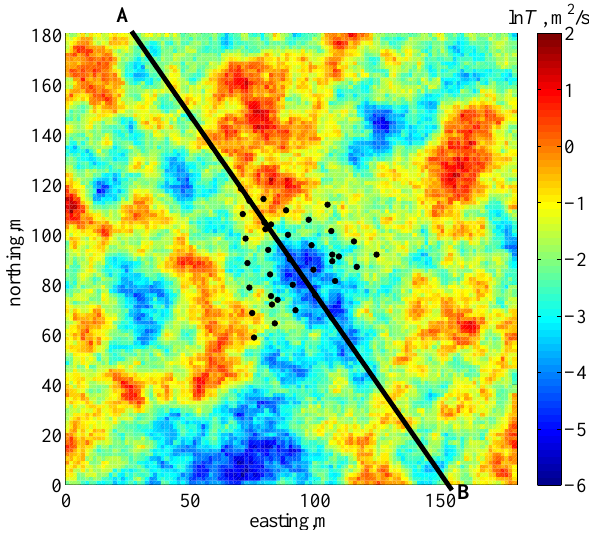
Fig. 4. Reference field for the synthetic study. Line A–B is used for the